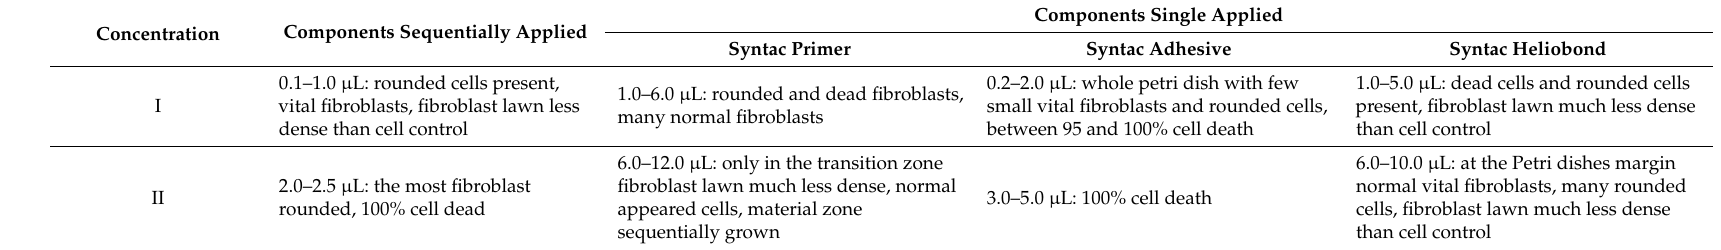
Table 8. Qualitative evaluation: Syntac (No.